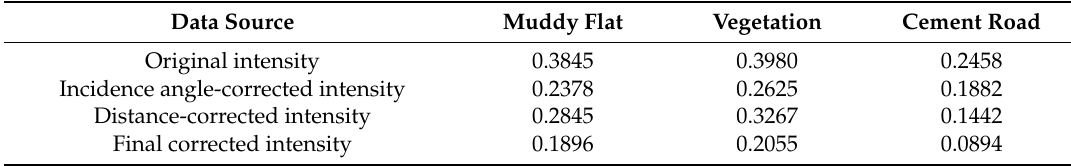
Table 3. Values of CV for the intensity data before and after